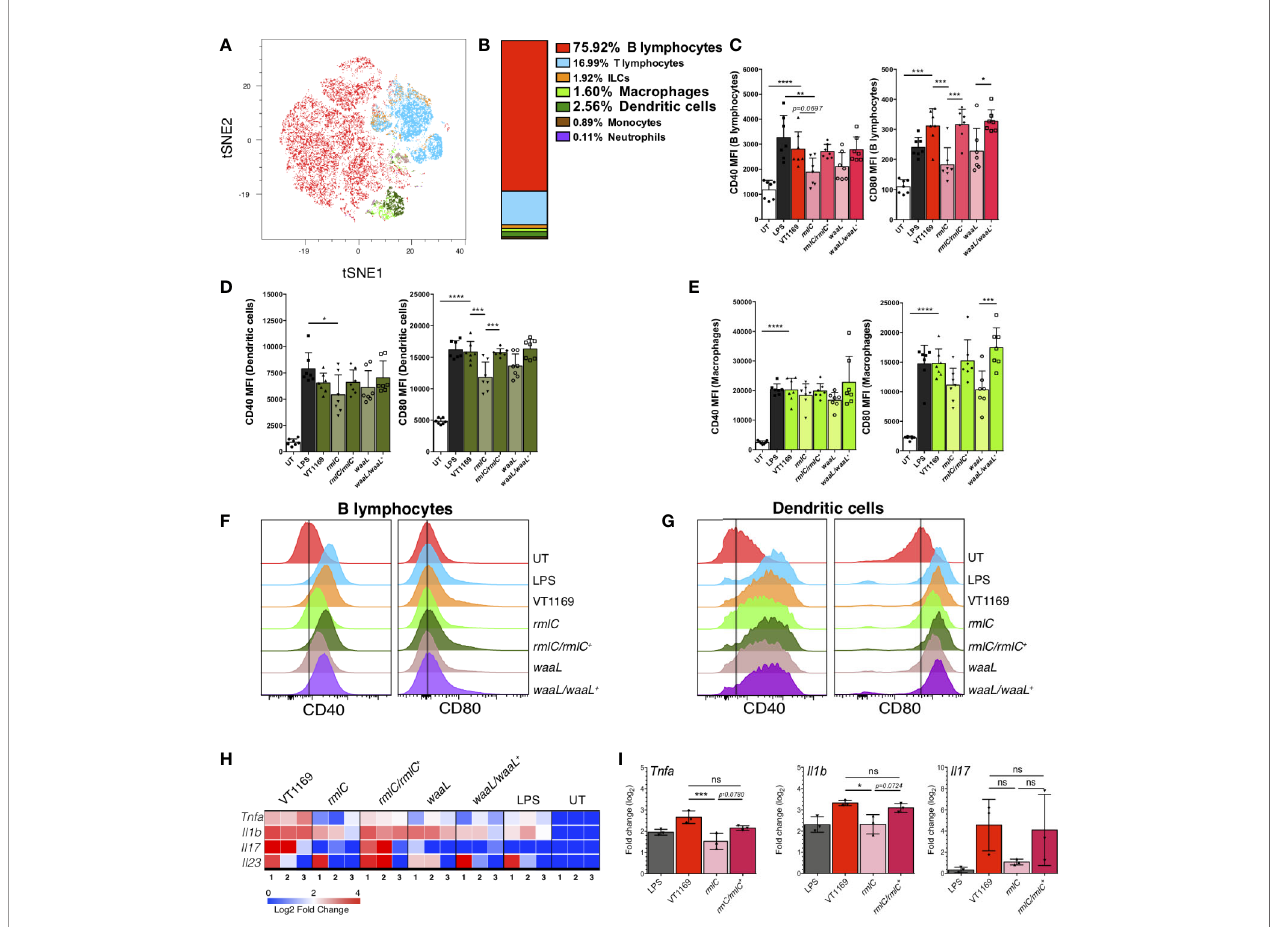
FIGURE 5 | B-lymphocyte, dendritic cell, and splenocyte responses against the different strains of A. actinomycetemcomitans . (A) tSNE map of 11-parameter fl ow cytometry data from untreated (UT) mice, color-coded as follows: B-cells in red, T-cells in cyan, innate lymphoid cells (ILCs) in orange, macrophages in light green, dendritic cells in dark green, monocytes in brown, and neutrophils in purple. (B) Percentage of each cell population described in (A) . Data pooled from two independent experiments (n=4). The MFI levels of the co-stimulatory molecules CD40 and CD80 are shown in (C) for B lymphocytes, (D) for dendritic cells, and (E) macrophages stimulated 20 h with the A. actinomycetemcomitans VT1169, rmlC , rmlC/rmlC + , waaL , or waaL/waaL + strains, and the E. coli -derived LPS-stimulated and UT cells, used as controls. The histograms representing the MFI levels of the co-stimulatory molecules CD40 and CD80 are shown in (F) for B lymphocytes and (G) for dendritic cells, under the same conditions experimental described in (C-E) . Data pooled from three different experiments (n=7). (H) Heatmap and (I) bar plots of qRT-PCR analysis of Tnfa , Il1b , Il17 , and Il23 transcripts in total splenocytes stimulated 8 h with the A. actinomycetemcomitans VT1169, rmlC , rmlC/rmlC + , waaL , or waaL/waaL + strains, and the E. coli -derived LPS-stimulated and UT cells, used as controls (n=3). Data pooled from two independent experiments. Mean ± SD, one-way ANOVA and Tukey post-hoc test, *p < 0.05, **p < 0.01, ***p < 0.001, ****p < 0.0001. Error bars represent SEM in all panels. Il , interleukin; LPS, E. coli - derived lipopolysaccharide; Tlr , toll-like receptor; Tnfa , tumor necrosis